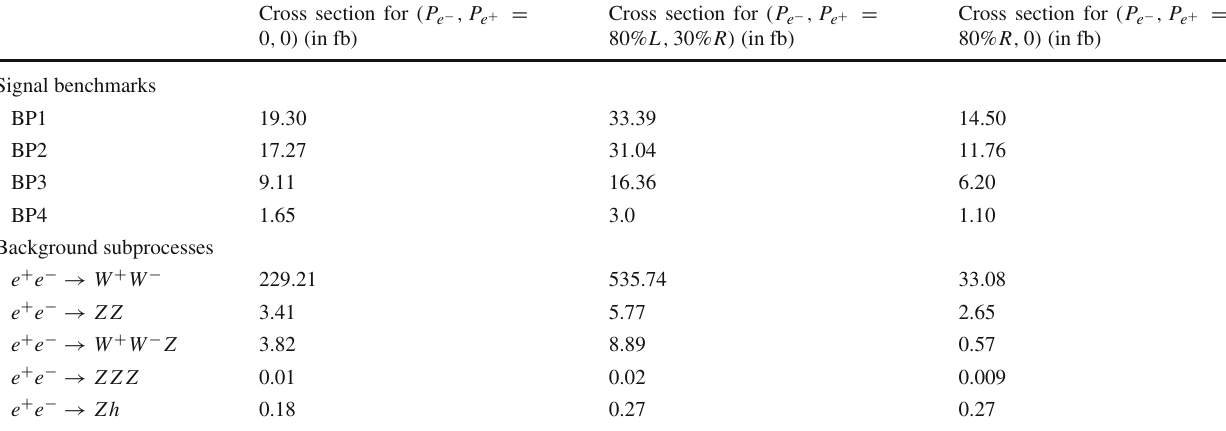
Table 9 The effective cross-sections of the signal and backgrounds for 1 (cid:10) + 2 j + E / T channel at LO at 1 TeV ILC using unpolarised and polarised incoming beams Cross section for ( P e − , P e + = 0 , 0 ) (in fb)